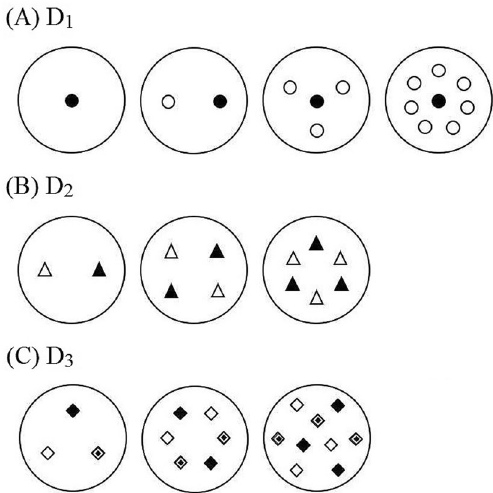
Figure 2. Distribution of Ceratocarpus arenarius plants from different dispersal unit morphs in pure (D 1 ) ( A ) and mixed [D 2 ( B ) and D 3 ( C )] densities. In ( A ), the target plant ( ) and its competitors from the same morph ( ); in ( B ), plants from a particular dispersal unit morph ( ) and the other morph ( ); and in ( C ), plants from dispersal units a ( ), c ( ) and f (